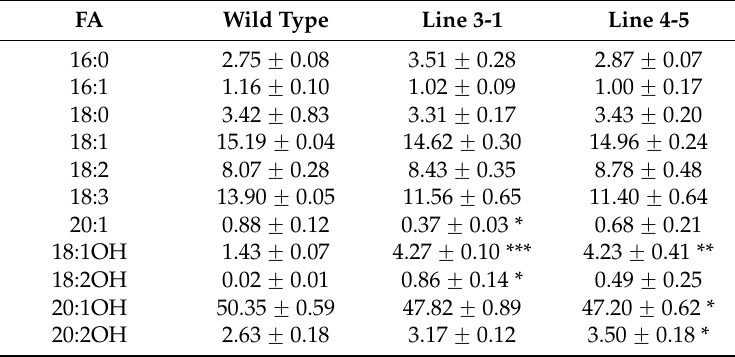
Table 2. Fatty acid (FA) composition of homozygous T 2